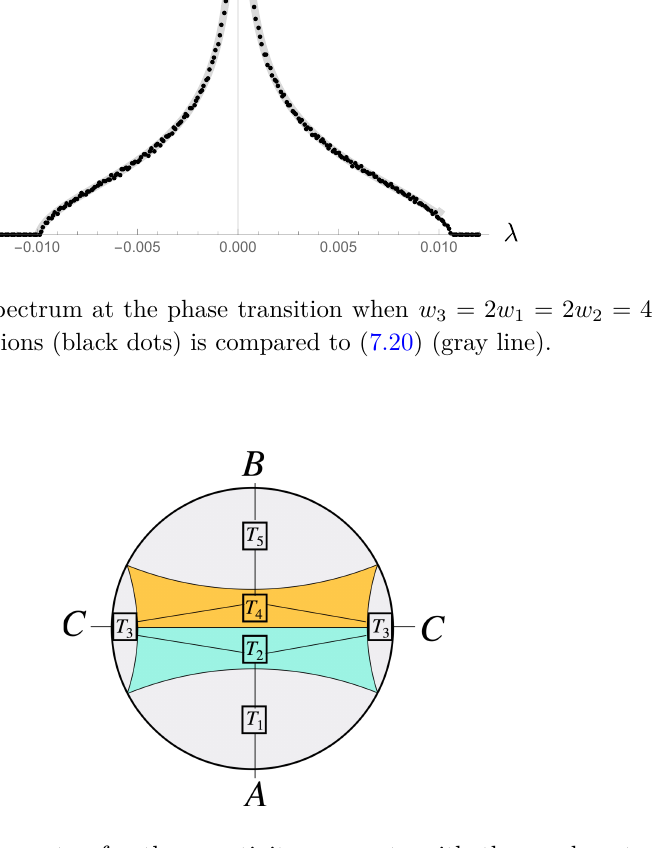
Figure 39 . The bulk geometry for the negativity moments with the random tensor network overlaid.